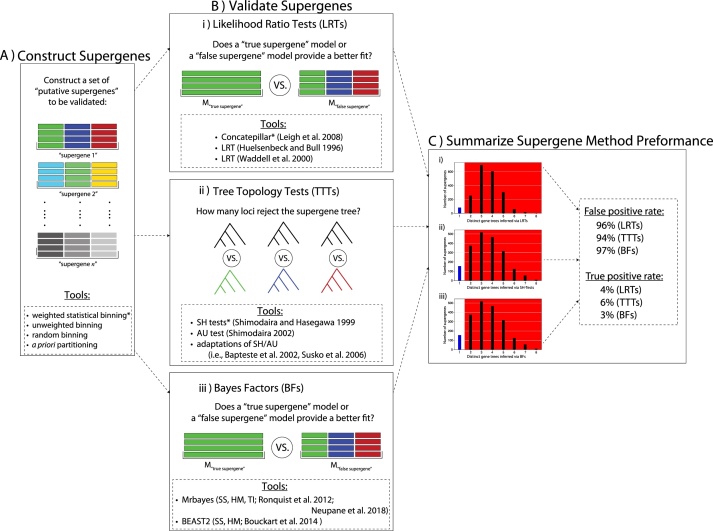
General framework for the supergene validation protocol as applied in Ref. [15]. First, a set of supergenes is obtained (a) either using an a priori concatenation strategy (i.e., partitioning loci into supergenes assumed to share a common tree), or using a heuristic supergene method (such as statistical binning). Here a supergene is depicted as a set of loci (colored alignments) that have been concatenated together to form a single alignment. After a set of supergenes has been constructed, we show three approaches (b) and associated example toolsets that can be used to assess supergene validity (i) Likelihood Ratio Tests (LRTs), (ii) Tree Topology Tests (TTTs), and (iii) Bayes Factor (BF) model comparison. For the LRTs, the fit of two alternative competing models (“true” vs “false” supergene models) is compared, and the best fit model indicates the reliability of the supergene (top box). A number of TTTs can be used to quantify the number of loci that reject or the overall supergene tree topology (i.e., colored vs gray tree shown in center box). BFs can be used in a similar manner to LRTs to compare the fit of “true” and “false supergene models (bottom box). Finally, the results of the supergene validation tests can be used to summarize the overall performance of the supergene method by estimating the number of supergenes that selected the “true” or “false” supergene models – providing an estimate of the false positive and true positive rate of the supergene method, respectively. Asterisks (*) indicate specific analyses used in the original supergene validation study of [15] (Concatepillar and SH tests).